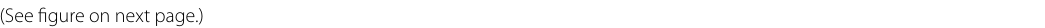
Fig. 2 Targeted gene replacement of MoXYL1A compromised turgor-mediated appressorium integrity and impaired the virulence of M. oryzae . a Showed hyphae-mediated virulence characteristics of the individual strains on intact and injured leaves of one-week-old, barley seedlings. induction of blast lesion was assessed at 7-dpi. Images are representative of three independent assays, each assay with three replicates. b Virulence bioassay conducted on 21-days-old rice seedlings using spore-drop inoculation method. Conidial suspensions were prepared as 1 10 5 conidia × mL − 1 in 0.2% Tween 20, for both the mutants and wild-type 20 µL. c Conidia-mediated pathogenicity/virulence characteristics Δ Moxyl1A, Δ Moxyl1B, and the wild-type on 21-days-old rice seedlings, through spray-inoculation with conidial suspensions (1 10 5 conidia mL − 1 in 0.2% Tween 20). × d The micrograph portrays the inability of Δ Moxyl1A and double deletion mutants to invade and colonize barley tissue at 48hpi. The absence of invasive hyphae were evident in barley cells inoculated with Δ Moxyl1A or the double deletion strain. In contrast, numerous invasive hyphae were seen in the leaves inoculated with either Δ Moxyl1B or Guy11. Images are representative of n 2 independent biological replicates. Scale = bar, 20 μm. e Appressoria were produced artificially on Thermo-fisher hydrophobic coverslips and observed at 8 hpi. Images show non-functional appressoria lacking melanin lining for the Δ Moxyl1A mutant. f Showed results from incipient cytorrhysis assays performed to evaluate the turgidity of appressorium form by conidia from the Δ Moxyl1A, Δ Moxyl1B, Δ Moxyl1A_Com., Δ Moxyl1B_Com., and the wild-type hydrophobic coverslips for 8-h appressorium formed were treated with 2 M glycerol solutions. Collapse appressorium were counted using the Olympus DP80 light microscope. Scale bar 20 μm. g The bar graph showed results from the statistical evaluation of the proportion of collapsed appressorium recorded in the = Δ Moxyl1A, Δ Moxyl1B, Δ Moxyl1A_Com., Δ Moxyl1B_Com., and the wild-type strains on hydrophobic coverslips for 8-h and treated independently with varying concentrations (1 M, 2 M, 3 M, and 4 M) of glycerol solutions during incipient cytorrhysis assays. Consistent results from three independent biological experiments with each consisting of five technical replicates were used for statistical analyses. For each independent biological experiment, 100 appressoria were counted (n 100*3). treatments yielding significant difference ( P 0.05) are denoted with = ≤